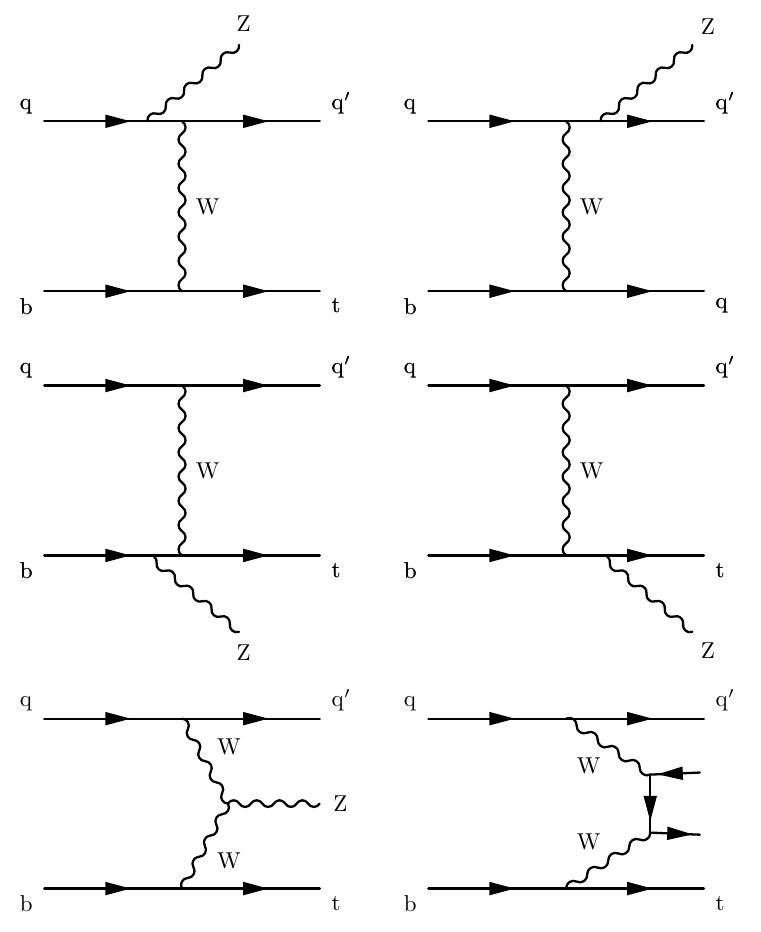
Figure 1 . Leading-order tZq production Feynman diagrams (all but bottom-right). The initial- and (cid:12)nal-state quarks denoted q and q 0 are predominantly (cid:12)rst generation quarks, although there are smaller additional contributions from strange- and charm-initiated diagrams. The bottom-right diagram represents the NLO nonresonant contribution to the tZq